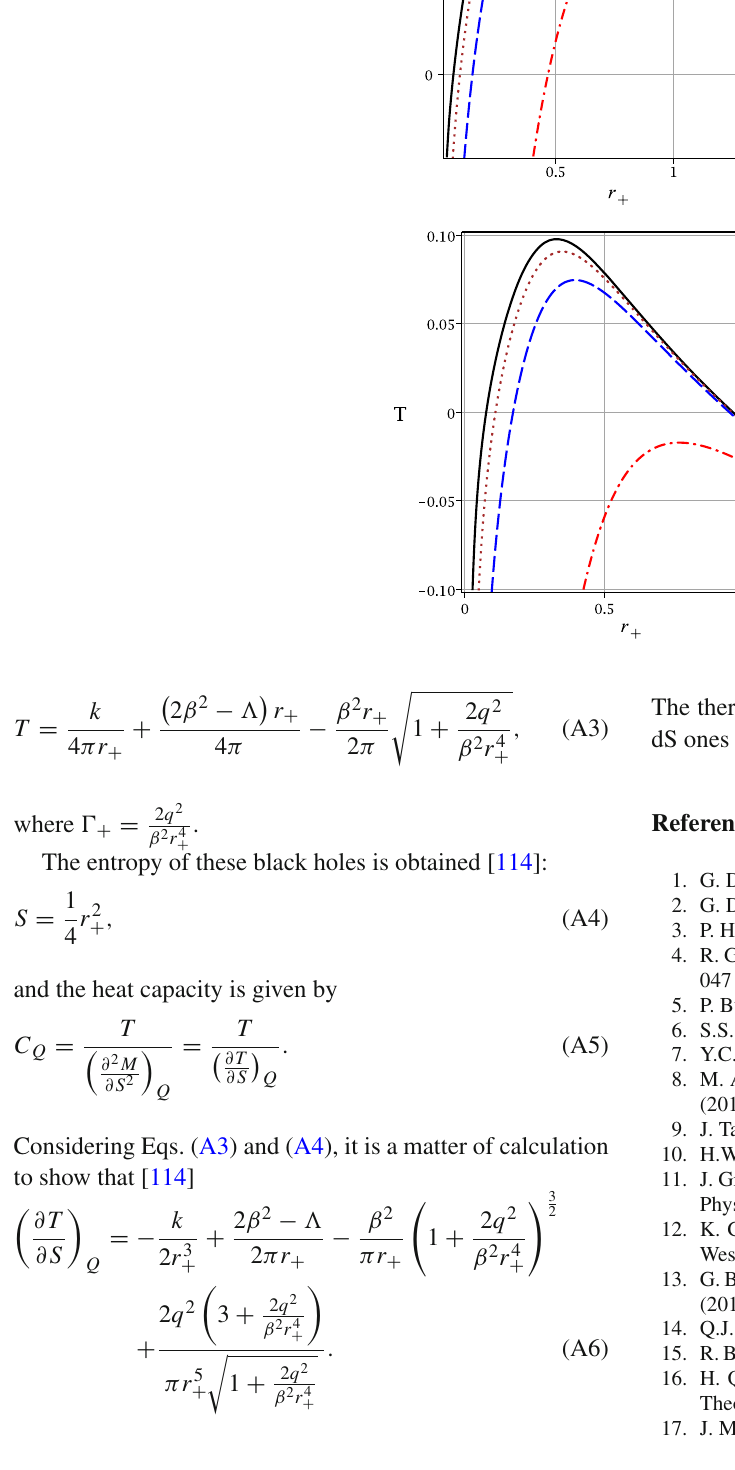
Fig. 8 T (left panel) and C (right panel) versus r + for β = 2 and k = 1; q = 0 . 26 (continues line), q = 0 . 27 (dotted line), q = 0 . 2964 (dashed line) and q = 0 . 6 (dashed-dotted line). Upper panels: (cid:16) = − 1; lower panels: (cid:16) =